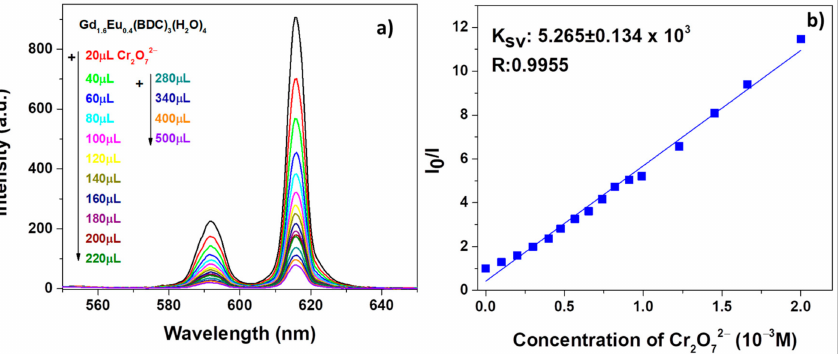
Figure 8. ( a ) Emission spectra and ( b ) Ksv curve Gd 1.6 Eu 0.4 (BDC) 3 (H 2 O) 4 (2 mg) dispersed into aqueous solution in the presence of various concentrations of Cr 2 O 7 2 − under excitation at 265